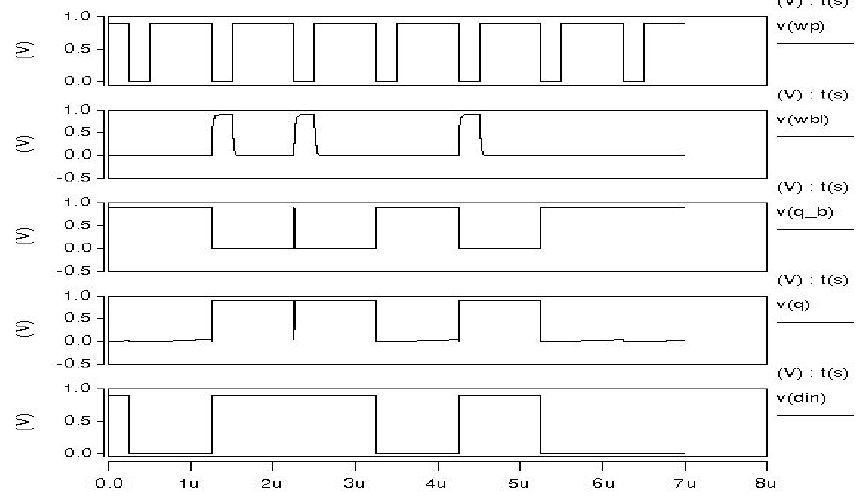
Figure 23. Waveform of write operations in CNFET (Sequence of